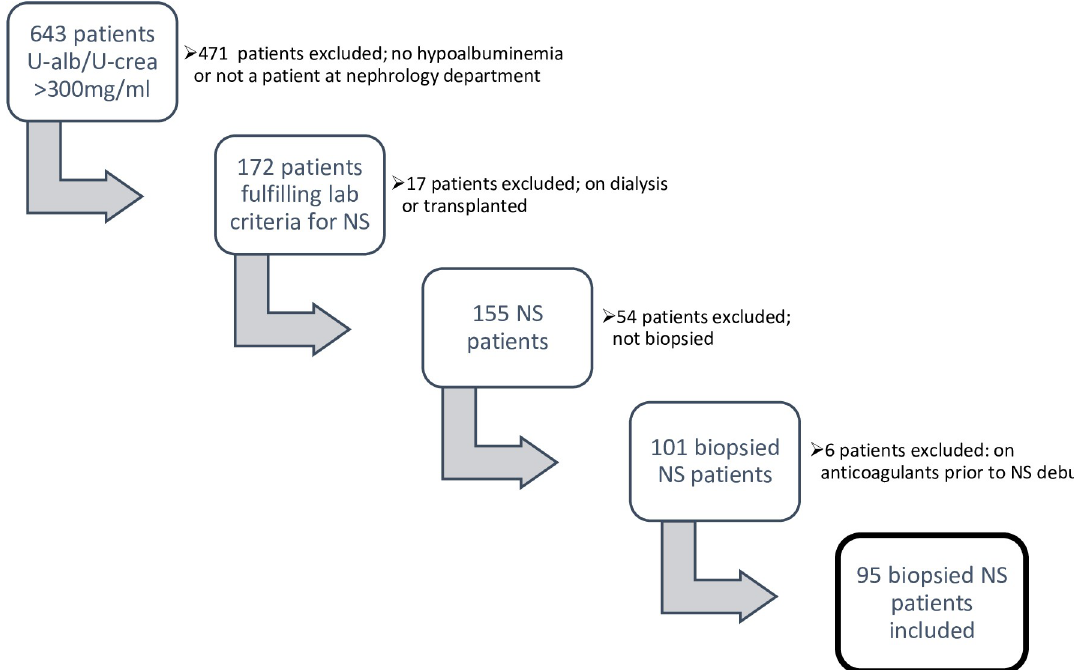
Fig 1. Steps of inclusion. Patients with U-albumin/U-creatinine > 300mg/ml or urine albumin > 3000mg /24 hours in Va¨sternorrland between January 1st, 2010 and July 31st, 2019 were found through a laboratory search (n = 643). Medical records were used to identify adults among those who also had hypoalbuminemia (S/P-albumin < 30g/L) and were in- or outpatients at a nephrology (n = 172) department in Va¨sternorrland. Patients who did not have a biopsy proven glomerular disease, were on renal replacement therapy (including kidney transplant recipients) or had anticoagulants prior to debut were excluded. Subsequently 95 NS patients were included.